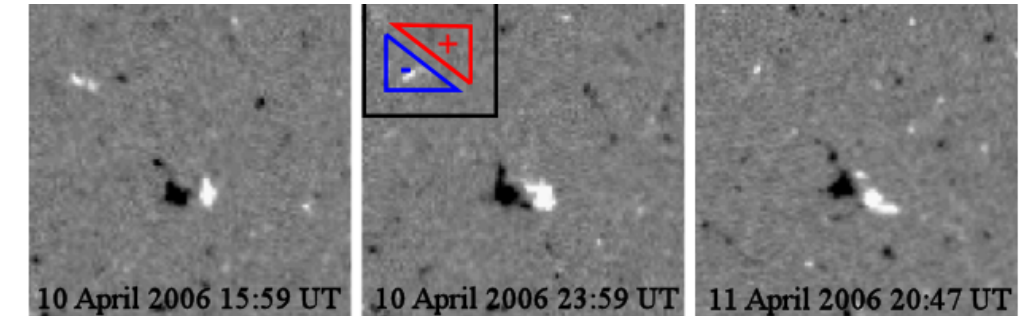
Fig. 5. Longitudinal magnetogram observations from SOHO/MDI of flux emerging in the small, Northern Hemisphere active region. White corresponds to positive polarity magnetic field, whilst black corresponds to negative polarity magnetic field. The first magnetogram (left) shows magnetic flux in the active region soon after it begins to emerge. In the second magnetogram (centre) the leading (positive) polarity field extends to the north of the following (negative) polarity field. Included on this magnetogram is a schematic illustrating the relative positions of two elongated “tongues” of opposite polarities when the emerging active region has a negative sign of helicity, as in the case of this active region. The last magnetogram (right) shows the well separated footpoints of the developed active region.